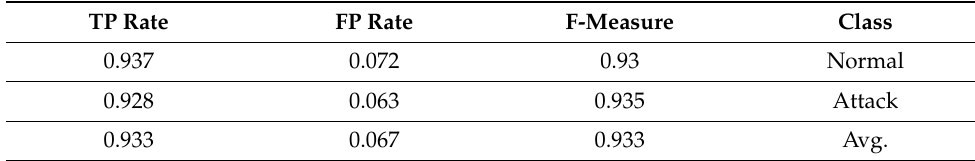
Table 8. Detailed accuracy of the C4.5 classifier.